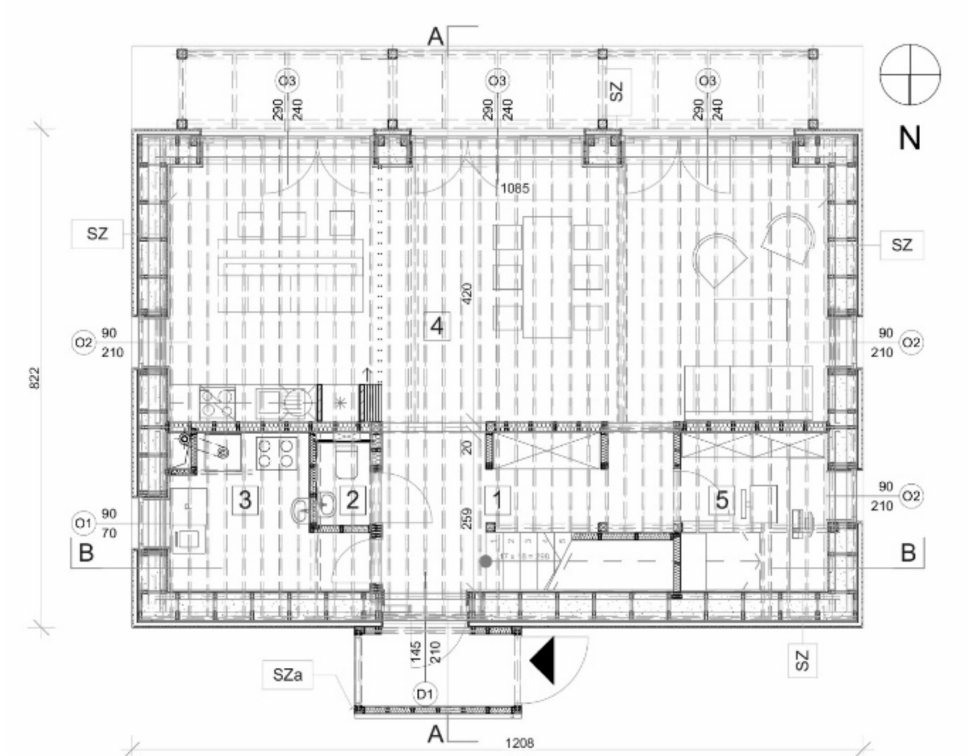
Figure 7. Model A2SB. Ground floor plan. Scale of 1:100. Source: own study using ARCHI- CAD software.